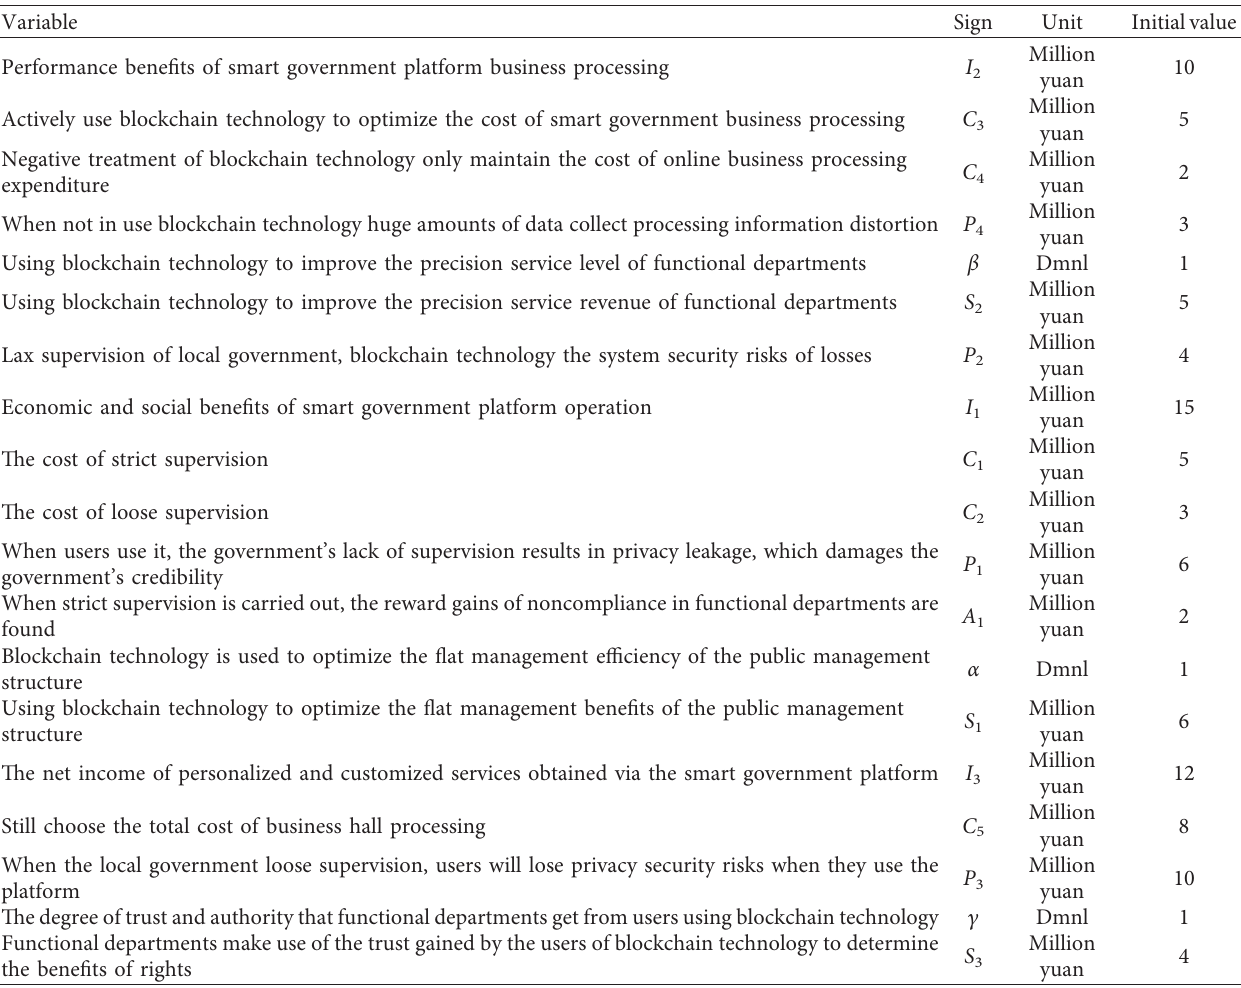
Table 4: Meaning and assignment of model